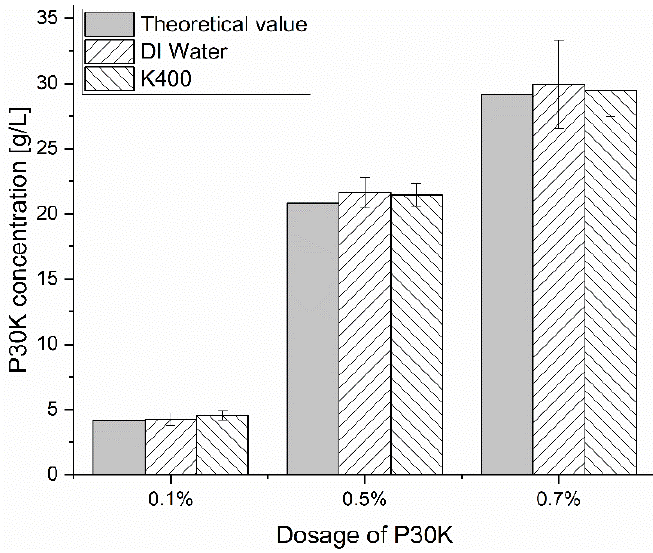
Figure 6. Comparison of the P30K concentration measured in the supernatant of GBS and the calculated theoretical value when no adsorption occurs.